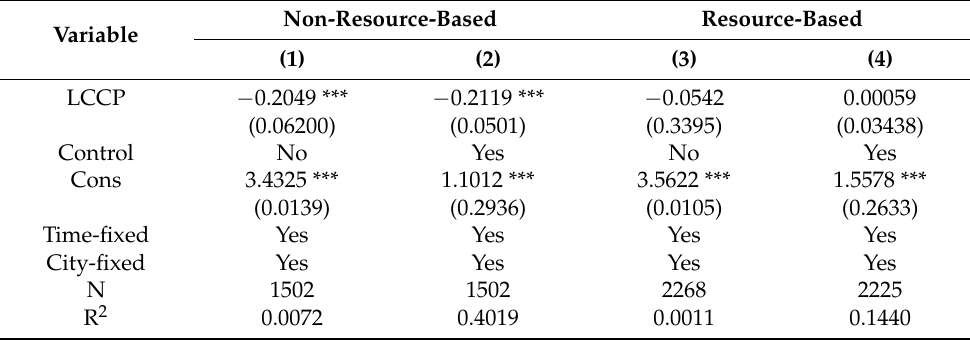
Table 7. Estimation results of analysis of urban resource dependence heterogeneity.